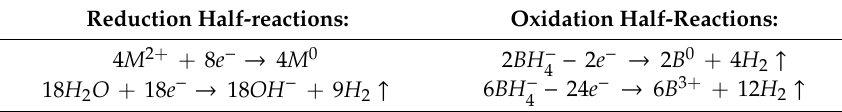
Table 4. Half-reactions of cobalt and nickel chlorides reduction by sodium borohydride. Reduction Half-reactions: Oxidation